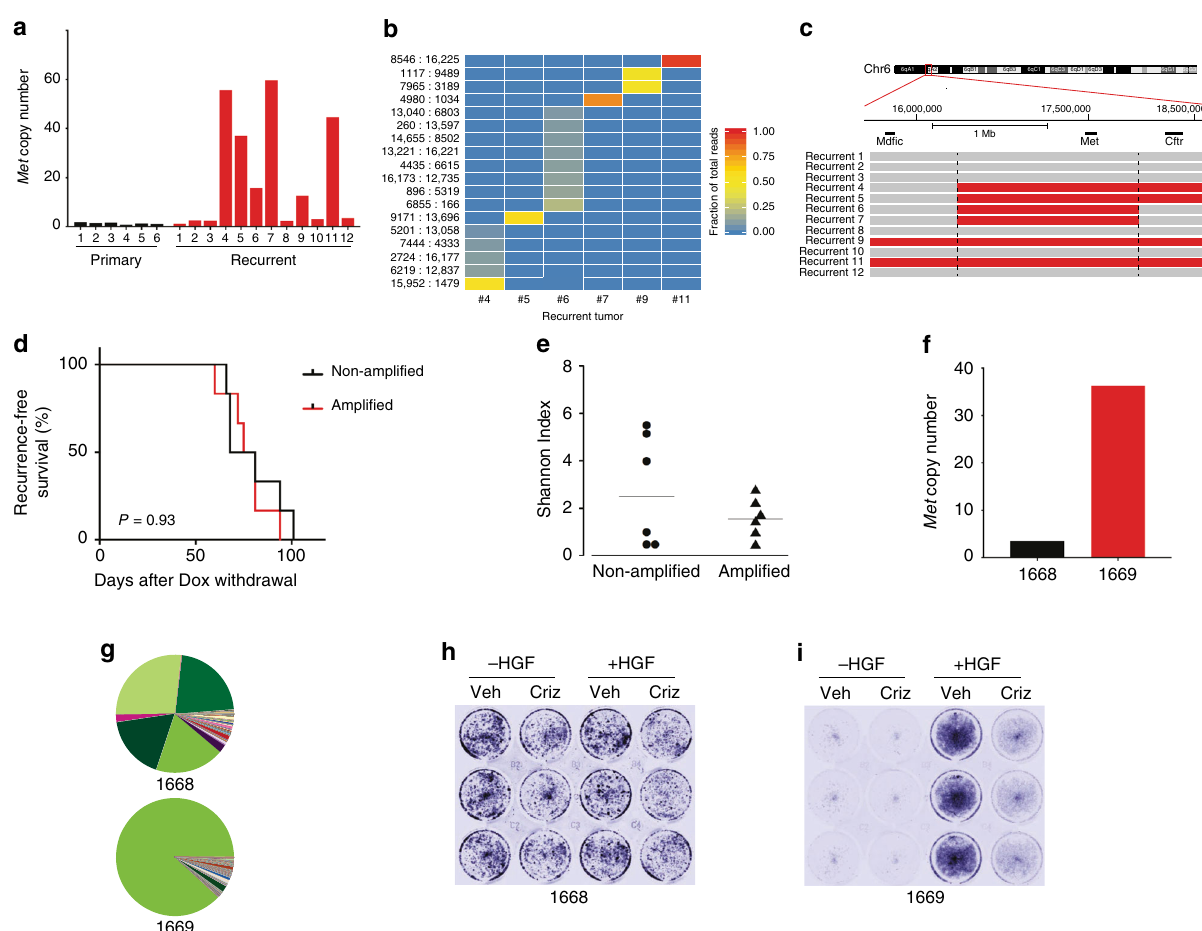
Fig. 4 Met ampli fi cation drives recurrence in a subset of clonal recurrent tumors. a qPCR analysis of Met copy-number in primary and recurrent tumors. Data are expressed as fold-increase in Met copy number relative to blood. n = 6 biologically independent primary tumors and n = 12 biologically independent recurrent tumors. b Heatmap of the abundance of selected barcodes in recurrent tumors, demonstrating that individual Met-ampli fi ed tumors have unique barcodes. All barcodes present at >5% in any tumor are shown. c Met-ampli fi ed recurrent tumors have distinct Met amplicons. qPCR analysis was used to measure Md fi c, Met, and Cftr copy number in individual Met-ampli fi ed tumors. Ampli fi ed regions are shown in red. d Kaplan – Meier recurrence-free survival curves for orthotopic tumors, strati fi ed based on Met ampli fi cation status. Differences in survival were calculated using the Kaplan – Meier estimator with the log-rank (Mantel-Cox) test. P = 0.637. e Shannon Diversity Index showing barcode complexity in recurrent tumors with and without Met ampli fi cation. n = 6 biologically independent recurrent tumors without Met ampli fi cation and n = 6 biologically independent recurrent tumors with Met ampli fi cation. f Met copy number in two cell lines derived from orthotopic recurrent tumors with or without Met ampli fi cation. n = 1 cell line without Met ampli fi cation and n = 1 cell line with Met ampli fi cation. g Pie charts showing the relative frequency of barcodes in cells from f . h – i Met signaling drives tumor cell proliferation in Met-ampli fi ed recurrent tumor cells. Recurrent tumor cells 1668 ( h ) or 1669 ( i ) were grown in the presence of HGF and/or crizotinib for 3 days. Cells were stained using crystal